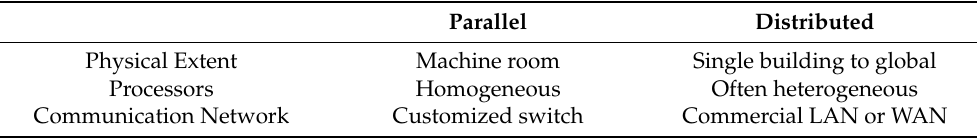
Table 1. Parallel and distributed computing